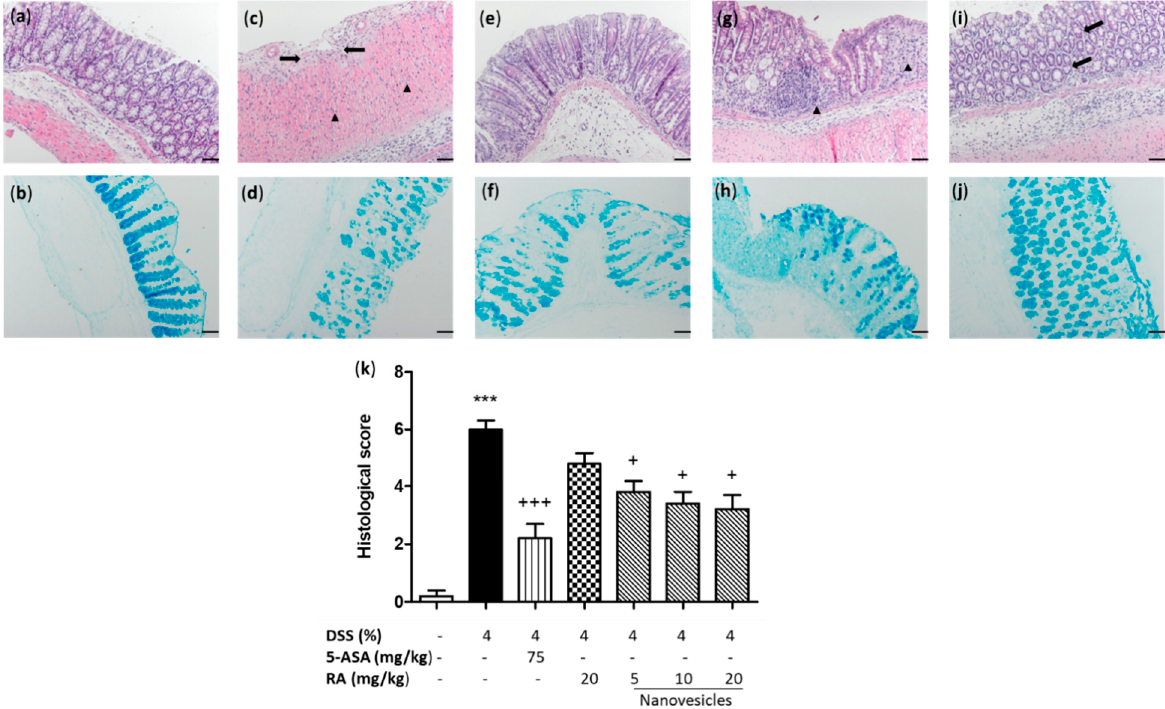
Figure 3. Rosmarinic acid (RA)-loaded nanovesicles administration attenuated DSS-induced microscopic colon damage and improved mucus accumulation inside the goblet cells. Histological images of colons following haematoxylin and eosin staining and Alcian blue staining: ( a , b ) sham group; ( c , d ) DSS group, ulceration (black arrows) and inflammatory cells (black triangle) in the lamina propria; ( e , f ) aminosalicylic acid (5-ASA) (75 mg/kg), ( g , h ) RA group (20 mg/kg), abundant inflammatory infiltrate (black triangle) and ( i , j ) RA-loaded nanovesicles (20 mg/kg, is shown as representative image of all the doses used), mucosal reparation and decrease of inflammatory infiltrate (black arrows). Original magnification 200 X. Scale bar: 50 µm. ( k ) Histopathological score of the colon was evaluated as indicated in the Methods section. Mean value was significantly different compared with the sham group (*** p < 0.001; Mann–Whitney U test). Mean value was significantly different compared with DSS group (+ p < 0.05, +++ p < 0.01; Kruskal–Wallis test).